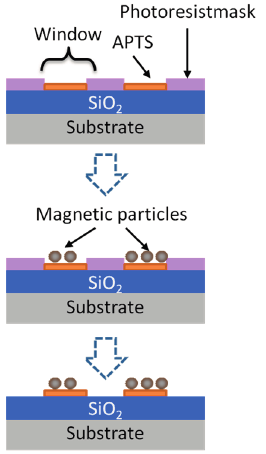
Figure 4. The procedure to immobilize nano-sized magnetic particles partially on the surface of thermally-oxide silicon substrate. Adapted from